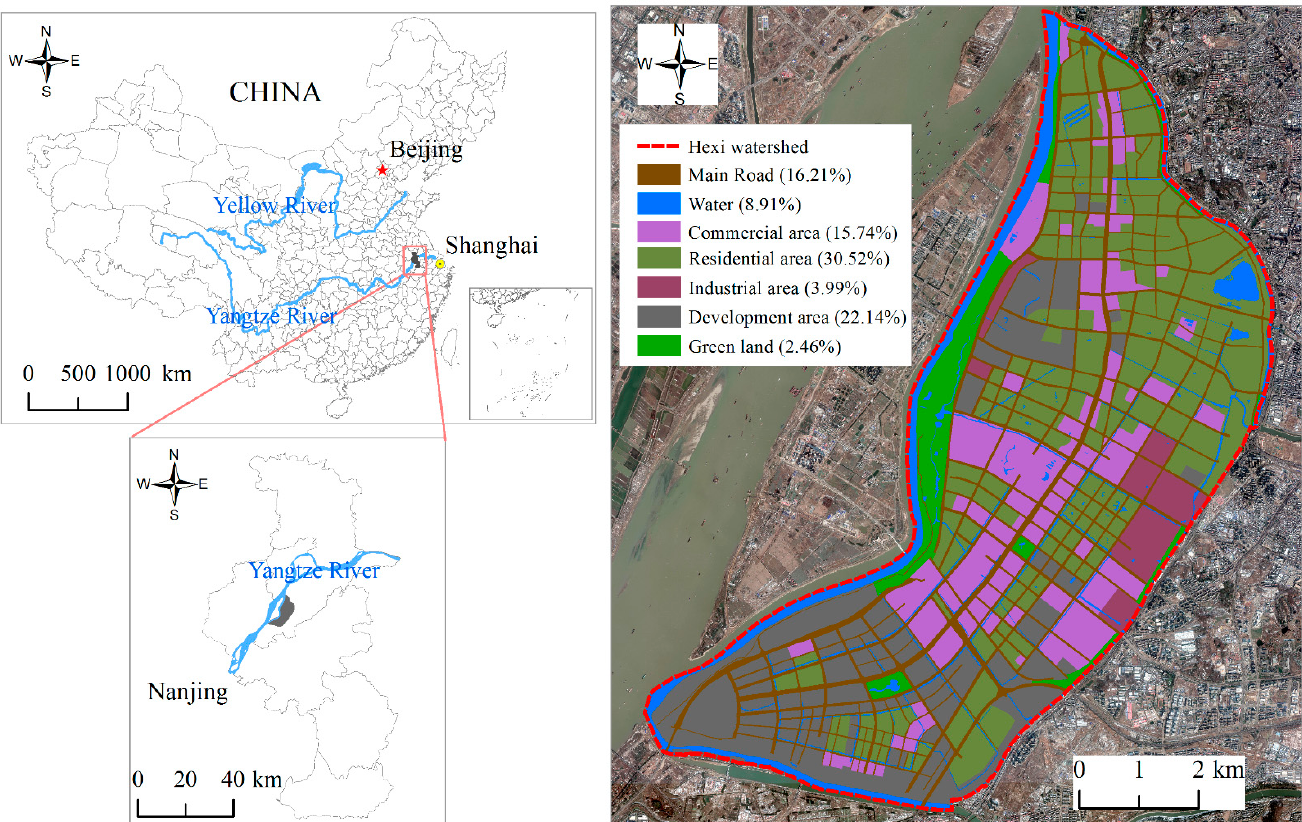
Figure 1. Location of the Hexi watershed in Nanjing, China.